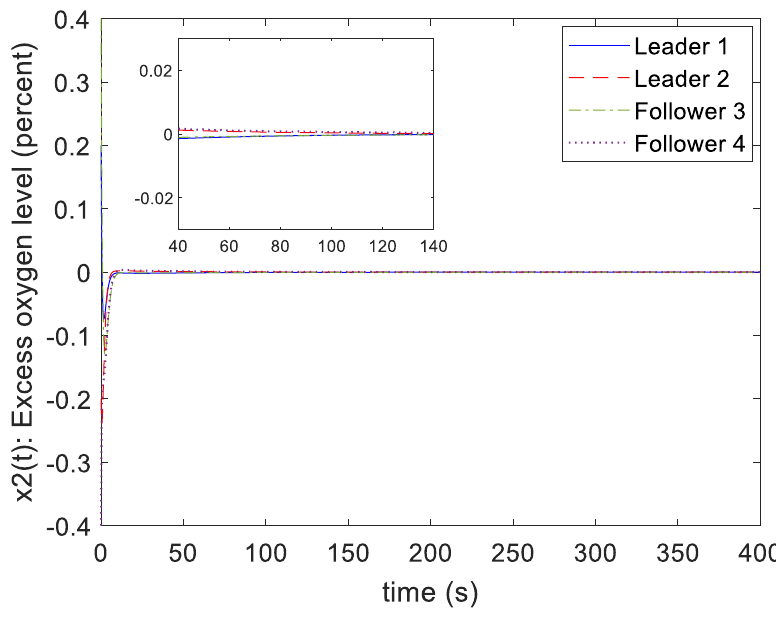
  x t with IT-2 fuzzy control. 1